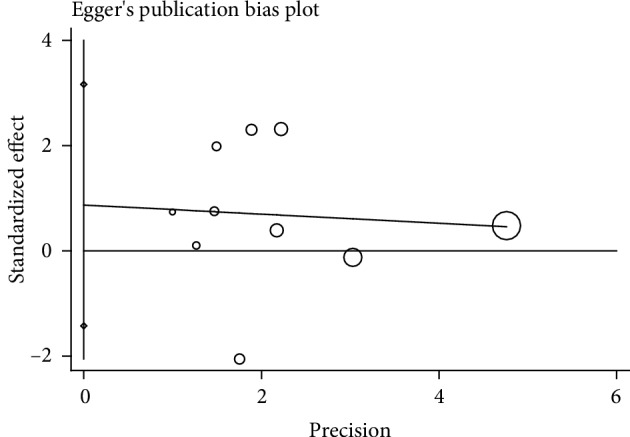
Publication bias.